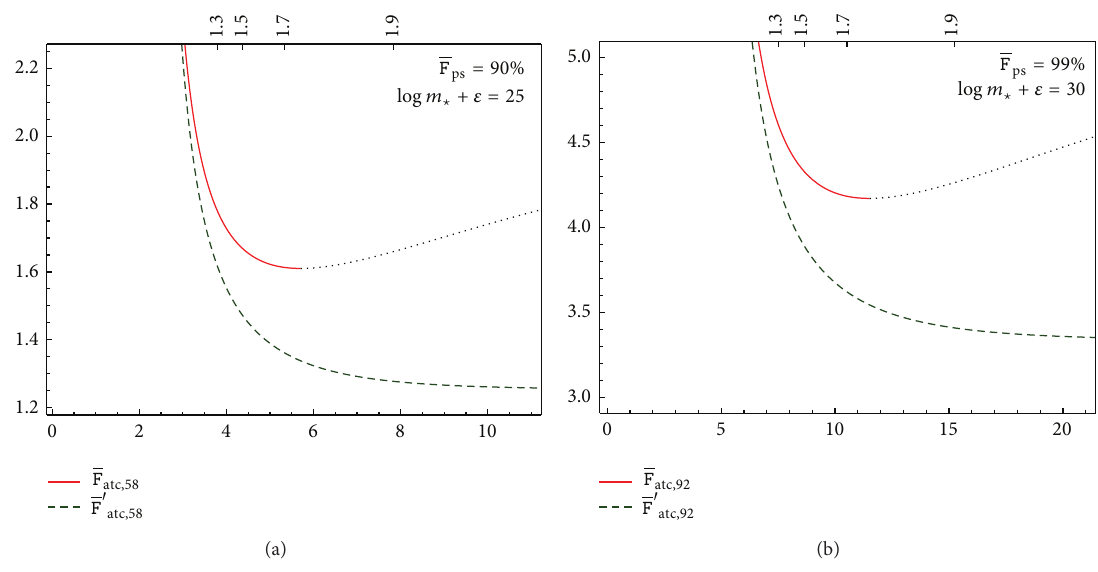
󸀠 in relation to F atc ,𝑠